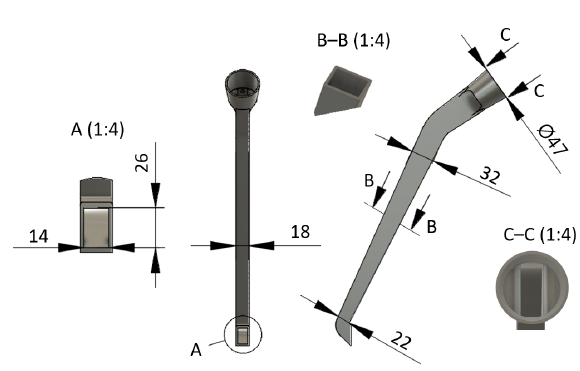
Figure 6: Schematic diagram of the fertilizer